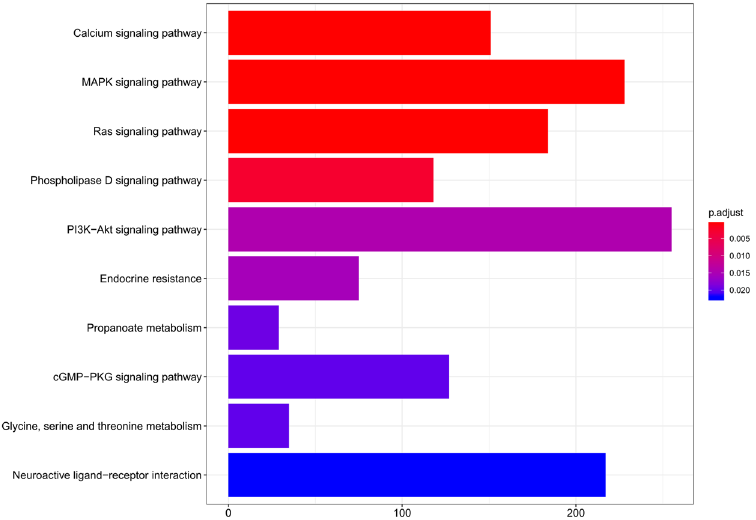
Figure 7. The first 10 Enriched KEGG pathways of DEMs in Cerebral Infarction. The x-axis indicates the number of DEMs participated in the pathway.